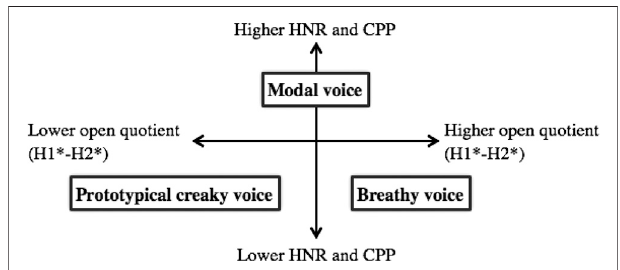
FIGURE 1 | Acoustic measures of breathy and creaky nonmodal phonation. Values (higher and lower) are presented relative to those for modal phonation (adapted from Garellek